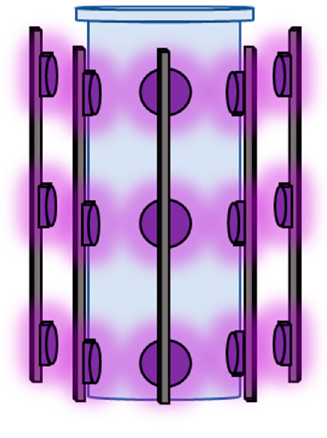
Figure 9. LED placement around the reactor.